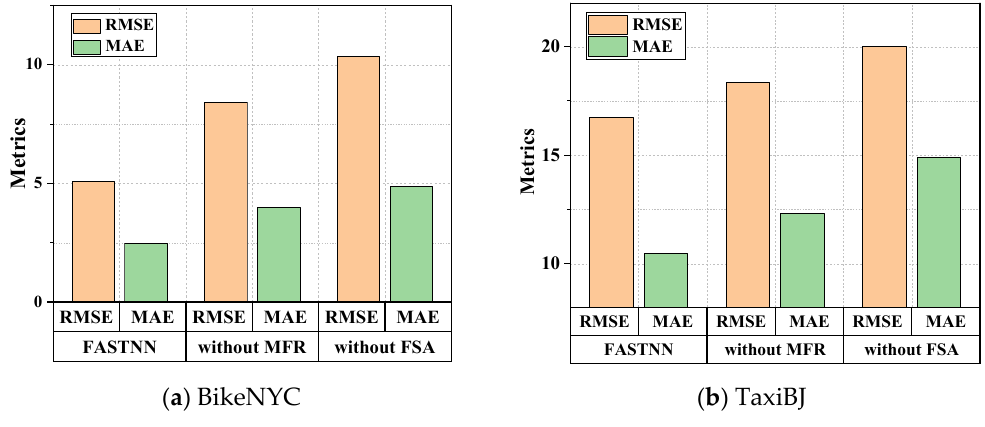
Figure 8 . Comparison of ablation experiments on two datasets . Figure 8. Comparison of ablation experiments on two datasets. Figure 9 visualized the real traffic flow and the prediction results of each Figure 9 visualized the real traffic flow and the prediction results of each model.